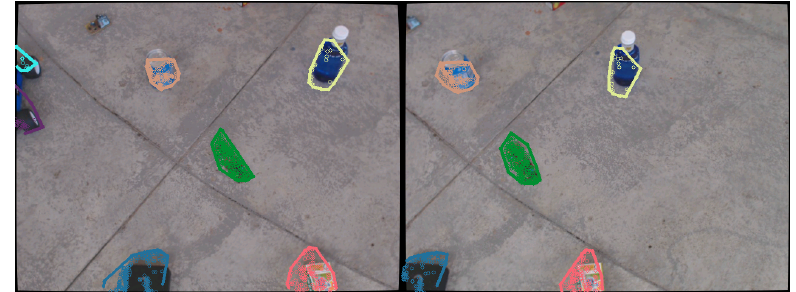
Figure 7. Reprojection of the points belonging to candidate objects, surrounded by a convex